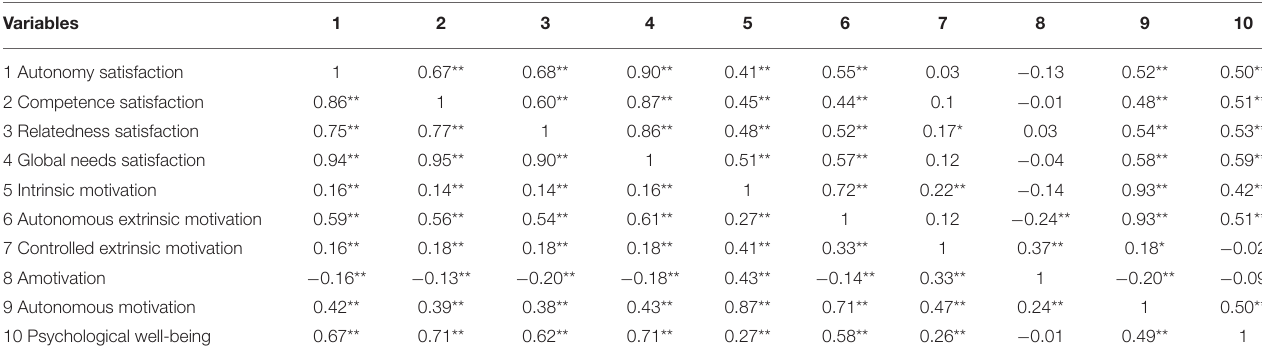
TABLE 2 | Correlation coefficients of the study variables in the Chinese (lower half, rows) and French samples (upper, columns).